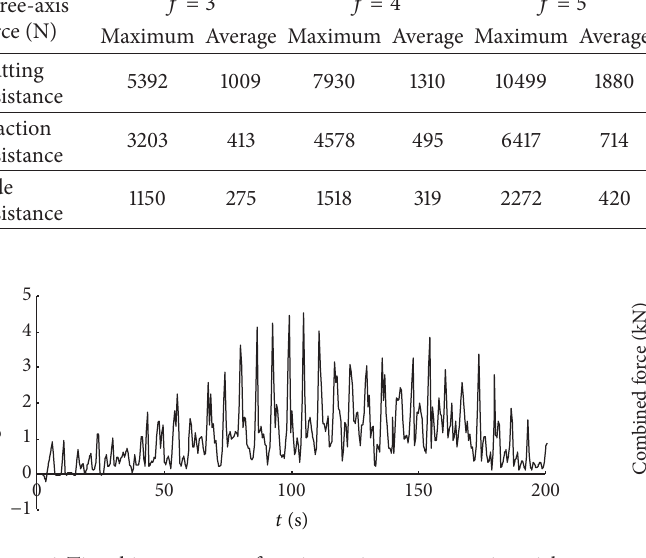
Figure 6: Time history curve of cutting resistance on cutting pick.